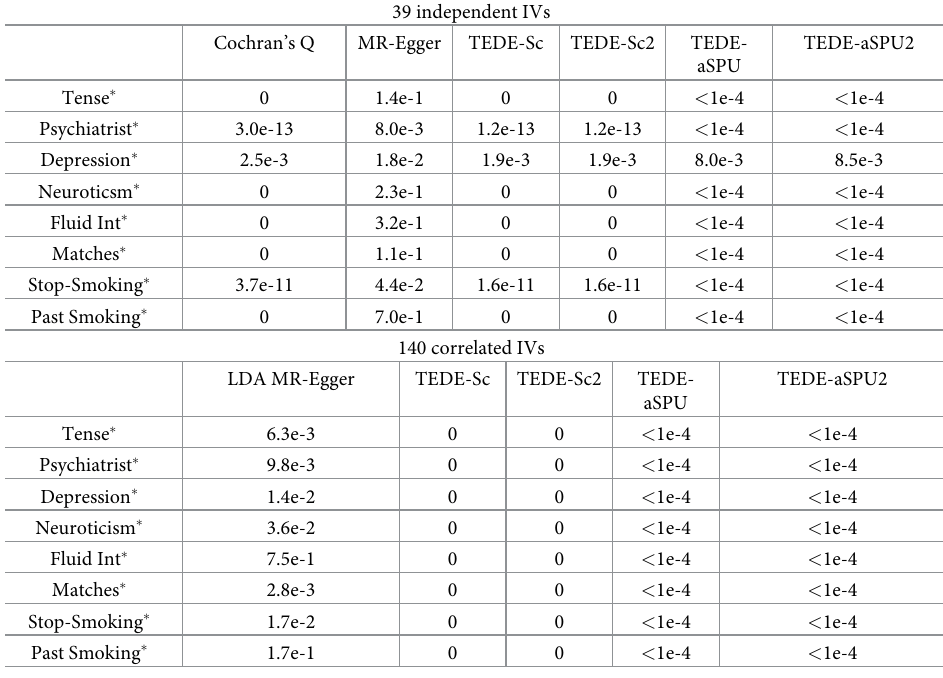
� Abbreviations for Tense / ’highly strung’; Seen a psychiatrist for nerves, anxiety, tension or depression; Non-cancer illness code: self-reported: depression; Neuroticism score; Fluid intelligence score; Number of incorrect matches in round; Number of unsuccessful stop-smoking attempts; Past tobacco